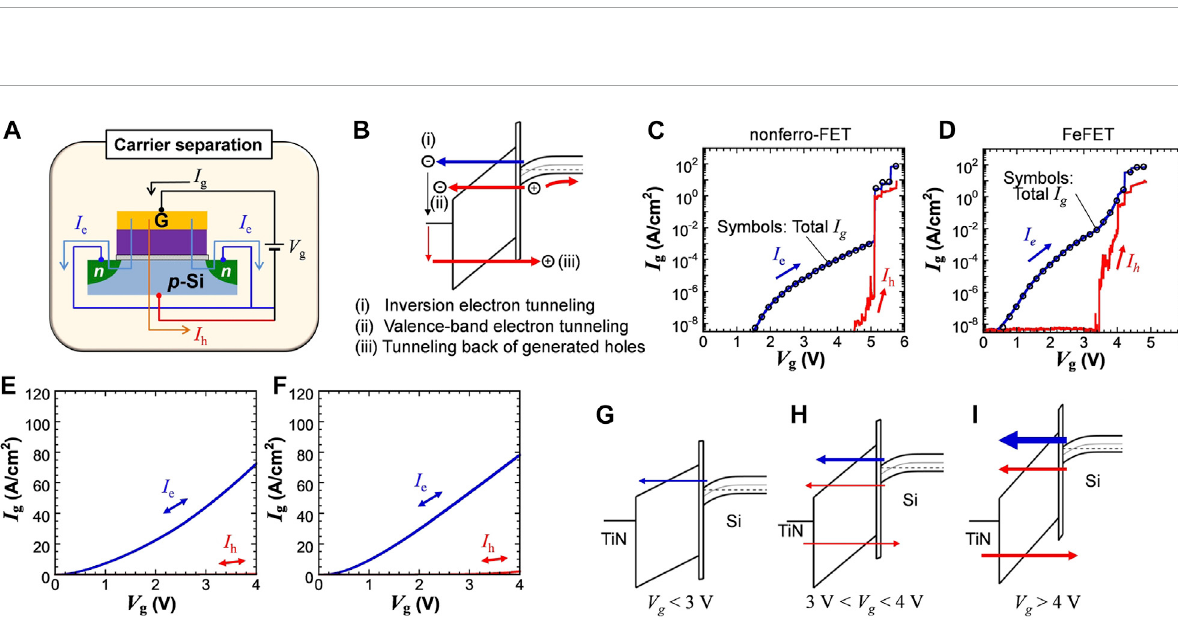
FIGURE 4 (A) Schematic of carrier separation measurement for analyzing gate current. (B) Current components in gate current. Inversion electron tunneling fl ows through S/D, while tunneling of valence-band electrons and generated holes appears as substrate current. Electron-component (blue lines), hole-component (red lines), and total (circle symbols) gate currents of (C) non-ferro-FET and (D) FeFET when V g was scanned from 0 V until the breakdown point. The electron component dominates the gate current while the hole component rapidly increases near the breakdownvoltage.Gatecurrentsafterbreakdownfor (E) non-ferro-FETand (F) FeFET,showingohmiccharacteristics.Banddiagramsandexpected gate current components at (G) low V g , (H) V g < V BD , and (I) V g > V BD